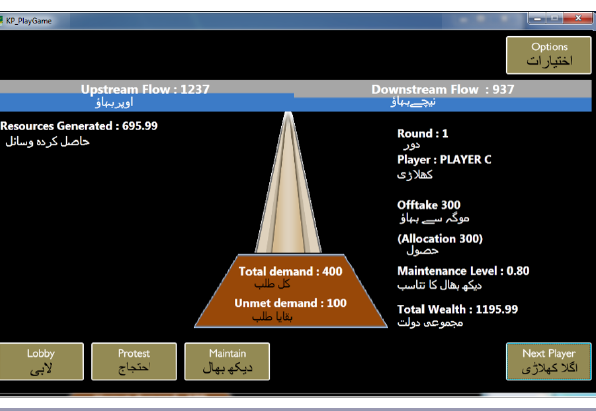
Fig. 2 . Sample game screen shown to players in each